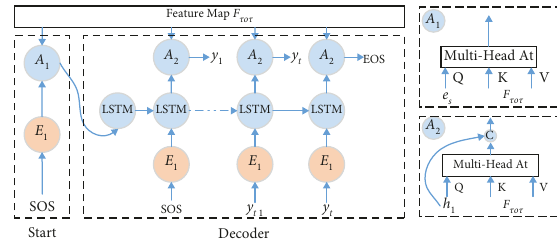
Figure 3: Details of the recognition